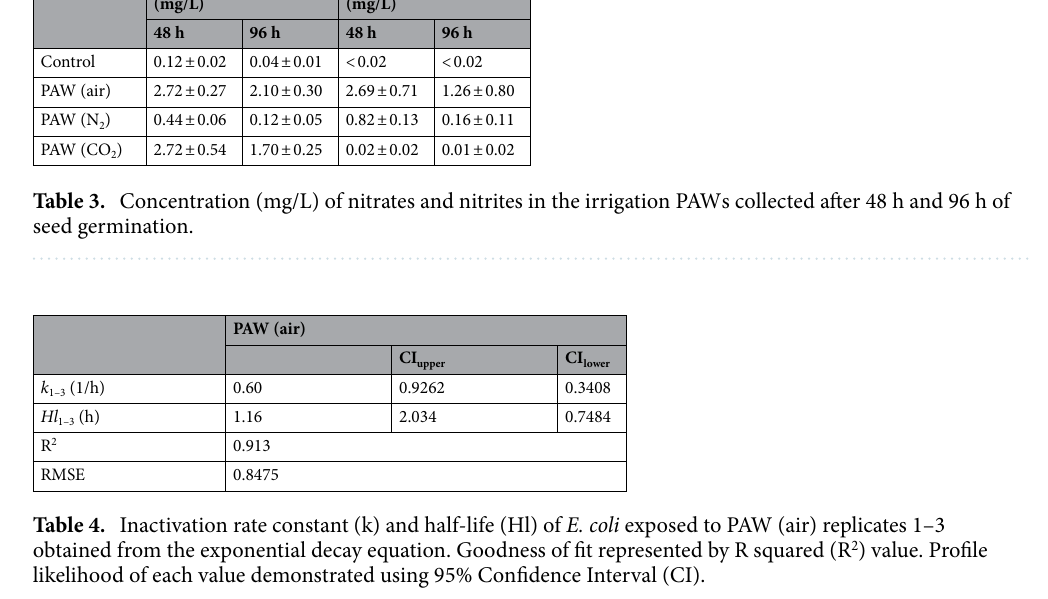
Nitrate concentration (mg/L)